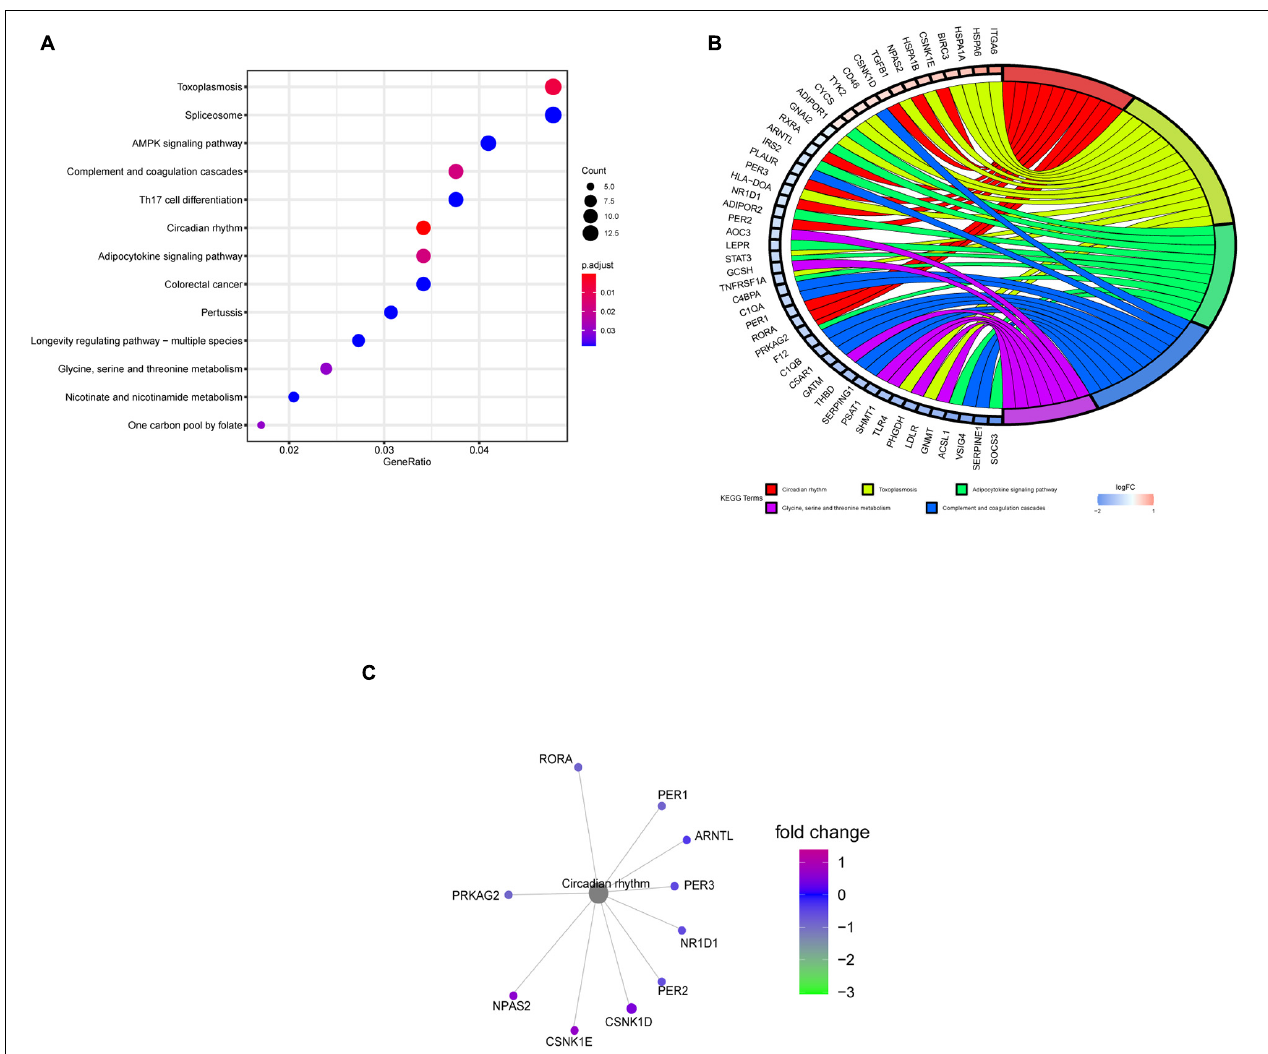
FIGURE 4 | KEGG pathway enrichment analysis of DERGs. (A) KEGG pathway analysis of DERGs. (B) KEGG pathway cluster analyses. (C) Significantly enriched genes in the circadian rhythm pathway.